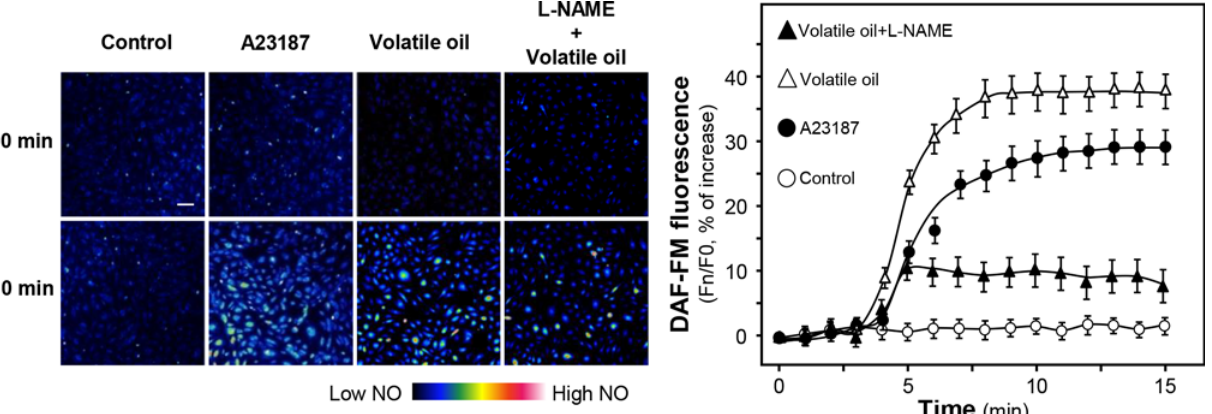
Figure 2. NRR volatile oil stimulates the production of NO in cultured HUVECs. Cultured HUVECs were pre-treated with serum free medium or L-NAME (100 µ M) for 3 hours, and then labeled with fluorescent NO indicator DAF-FM DA for 30 min. Then the cells were washed with 1X NPSS at pH = 7.4, and then fluorimetric measurement were performed after the treatment of volatile oil (25 µ g/mL), A23187 (1 µ M, positive control), or control (without drug treatment). The amounts of NO were evaluated by measuring the fluorescence intensity excited at 495 nm and emitted at 515 nm. Micrographs were taken by the confocal microscope. Bar = 100 µ m. (left panel). Quantification of intracellular NO production was displayed as a ratio of fluorescence intensity at any time (Fn) to the control at time 0 (F0) in the cultures (right panel). Mean ± SEM, n =